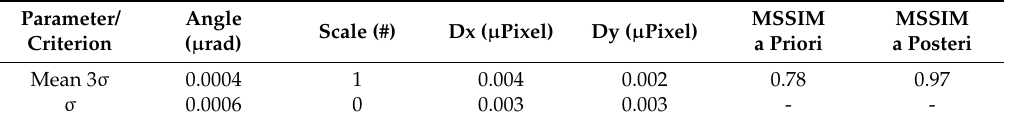
Table 3. Exemplary results for SIFT point